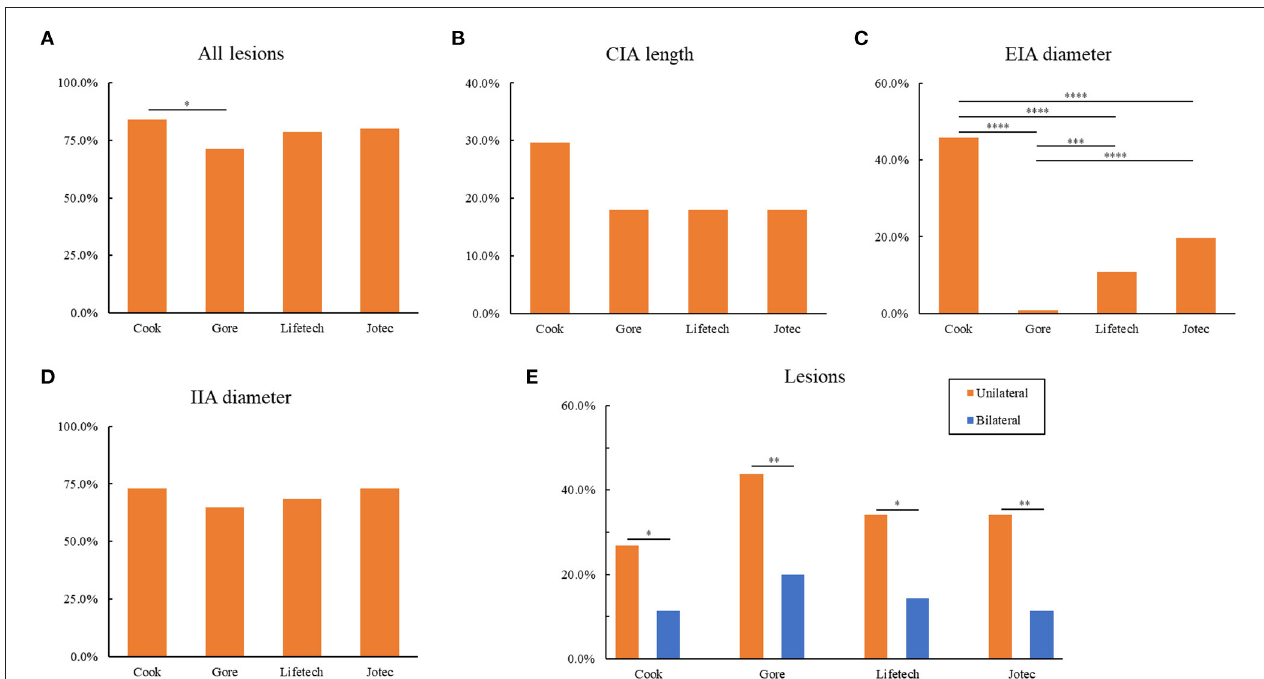
FIGURE 1 | Exclusion for IBDs based on anatomical characteristics. (A) Exclusion of all lesions for four IBDs. (B) Exclusion of CIA length for four IBDs. (C) Exclusion of EIA diameter for four IBDs. (D) Exclusion of IIA diameter for four IBDs. (E) Comparison of the exclusion of unilateral and bilateral lesions for four IBDs. * P < 0.05; ** P < 0.01; *** P < 0.001; **** P < 0.0001; as determined by Chi-square test. IBD, iliac branch device; CIA, common iliac artery; EIA, external iliac artery; IIA, internal iliac artery.